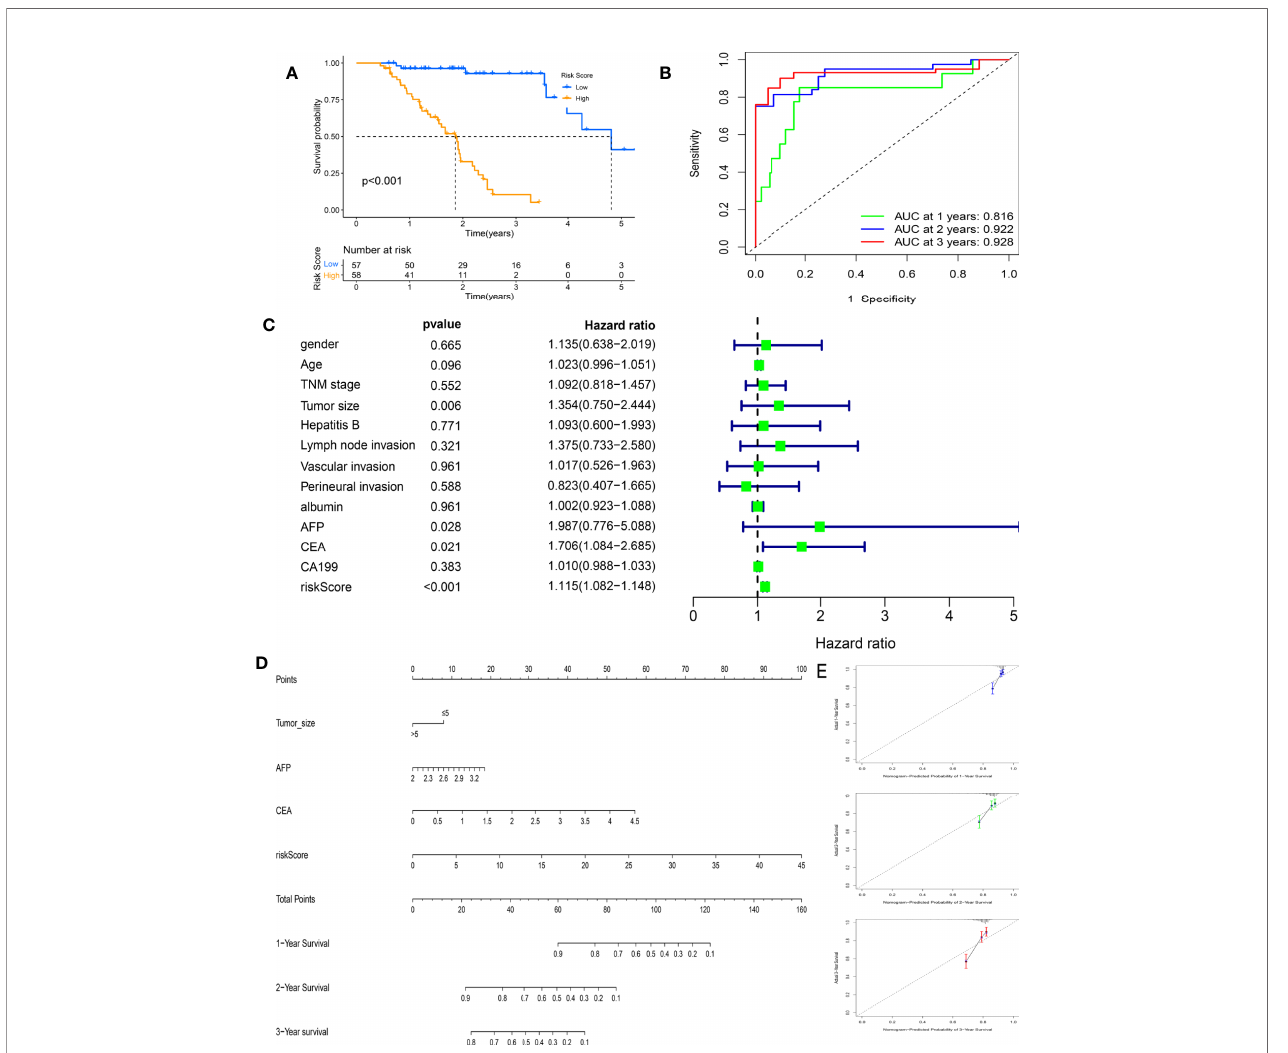
FIGURE 9 | Clinical prognostic value of the risk score in the First Af fi liated Hospital of Wenzhou Medical University (FAHWMU) cohort (n = 115). (A) The Kaplan – Meier (K-M) survival curve indicates the difference in overall survival (OS) in the different risk scoring groups. (B) The time-independent receiver operating characteristic (ROC) curve of the risk score. (C) The univariate Cox regression analysis of the risk score and clinical characteristics (including gender, age, TNM stage, tumor size, hepatitis B, lymph node invasion, vascular invasion, perineural invasion, albumin, alpha-fetoprotein (AFP), carcinoembryonic antigen (CEA), and carbohydrate antigen 19-9 (CA199)) regarding OS. (D) The nomogram combines the risk score and clinical characteristics signi fi cantly related to OS (p < 0.05). (E) The calibration curves are used to verify the nomogram in the 1st, 2nd, and 3rd